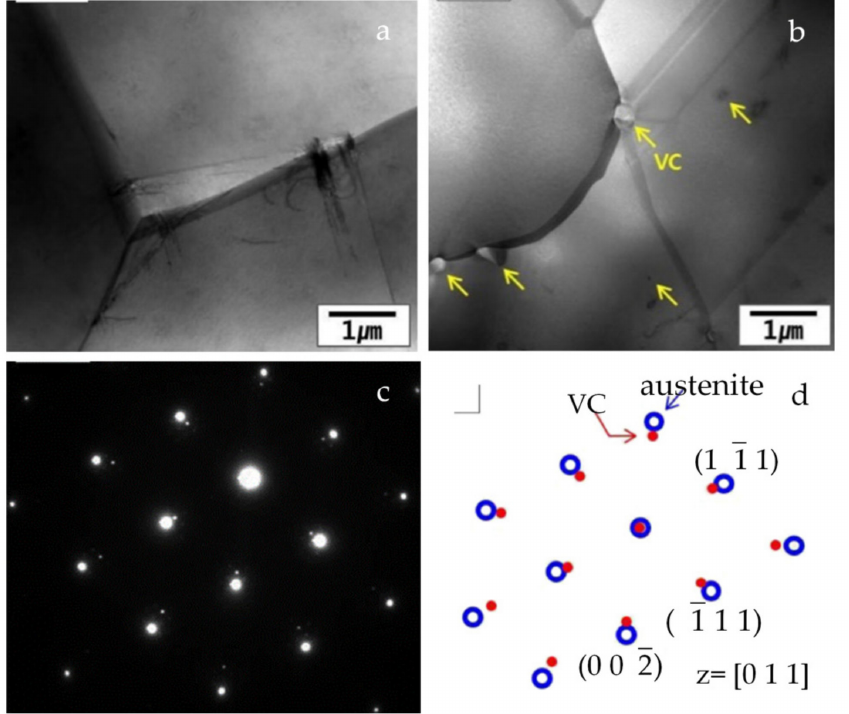
Figure 3. TEM micrographs of base steels ( a ) bright field image of steel 0 V, ( b ) bright field image of steel 0.5 V, ( c ) SAD pattern with Z = [011] and ( d ) computer simulated SAD pattern